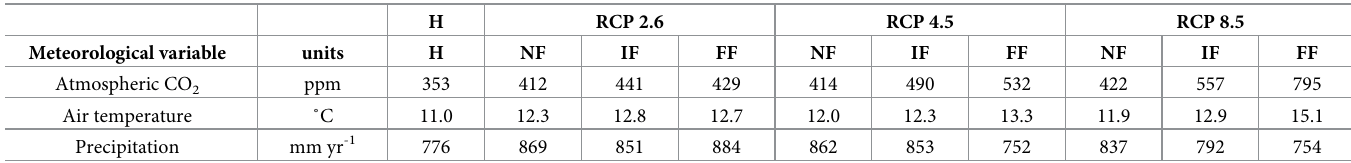
Table 1. Averages of projected annual climate variables (atmospheric CO 2 concentration, air temperature and annual precipitation) under the three selected RCP scenarios (RCP 2.6, RCP 4.5 and RCP 8.5) over the four different time slices: Historical (H), near future (NF), intermediate future (IF) and far future